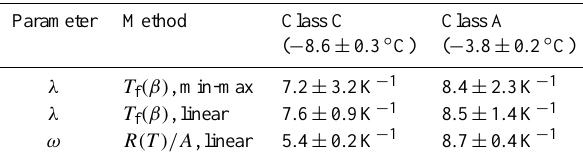
Table A2. Values of λ and ω determined using different approaches for the two investigated IN classes at their median freezing temper- ature (given in brackets); for details see text. These data are shown also in Fig.